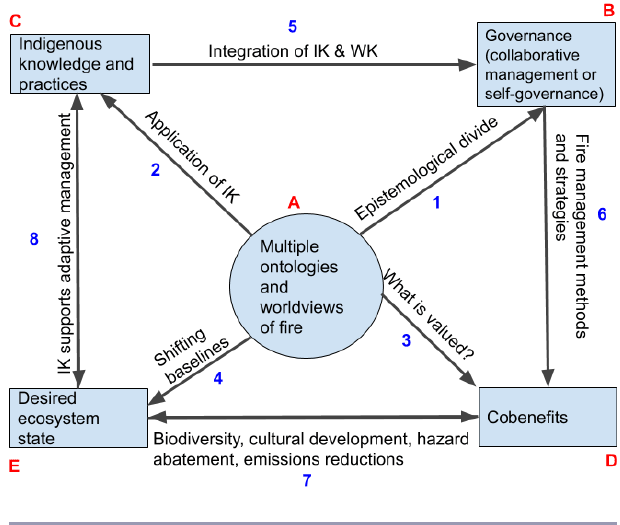
Fig. 2 . Conceptual model. IK, Indigenous knowledge; WK, Western